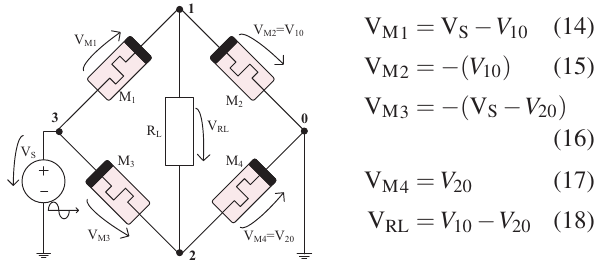
Fig. 2 : Schematic of the memristor bridge